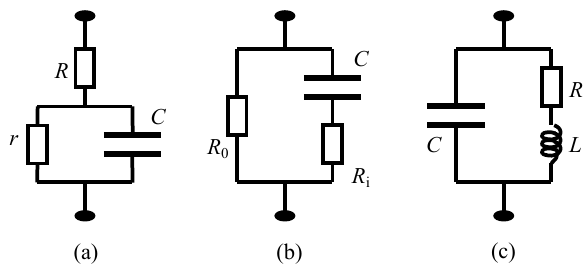
Figure 3 : Equivalent circuits proposed for: (a) tissues and compacted red blood cells by Philippson [20]. R and r are attributed to the cytoplasm and membrane resistance, respectively, and C to the membrane capacitance; (b) red blood cell suspensions proposed by Fricke & Morse [5], in which R 0 is the resistance to current flow around the cell, and R i is the cytoplasm resistance; (c) the squid giant axon by Cole & Baker to account for their discovery of the inductive reactance [26]. The values for R , C and L were determined as 1 k Ω cm 2 , 1 µ F/cm 2 and 0.2 H cm 2 ,